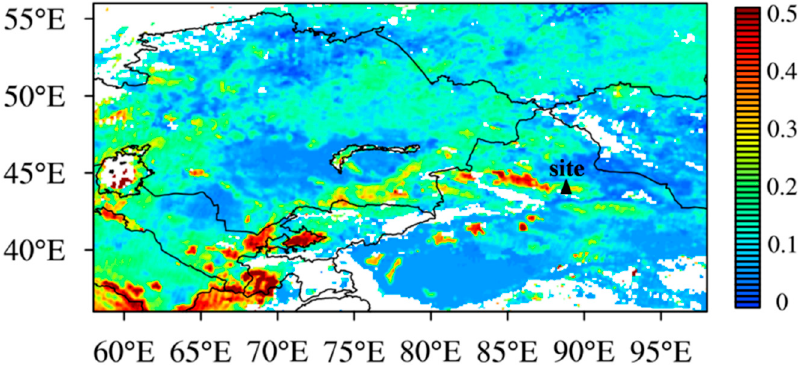
2.5 from the MIX emission inventory.